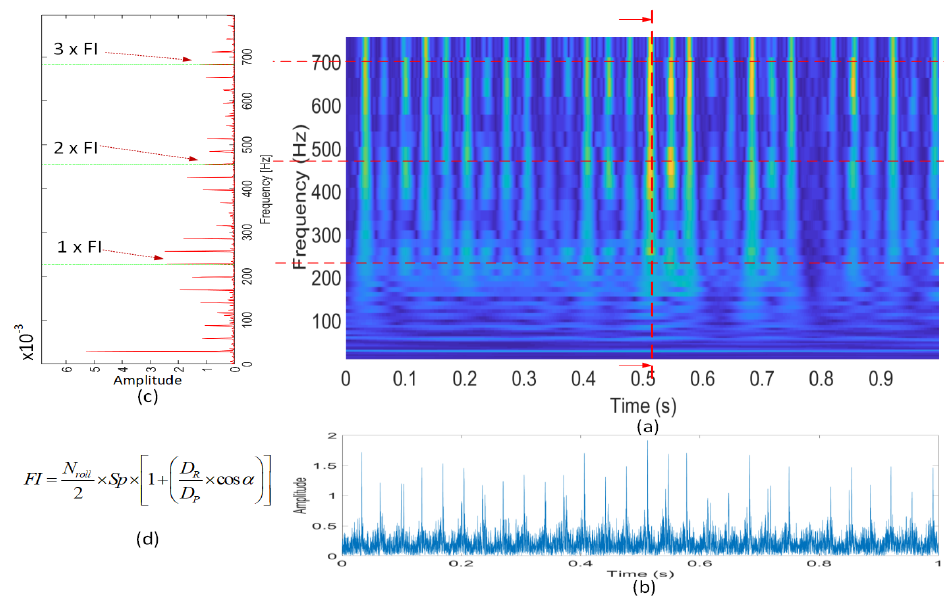
Figure 3. Figure 3. Cont